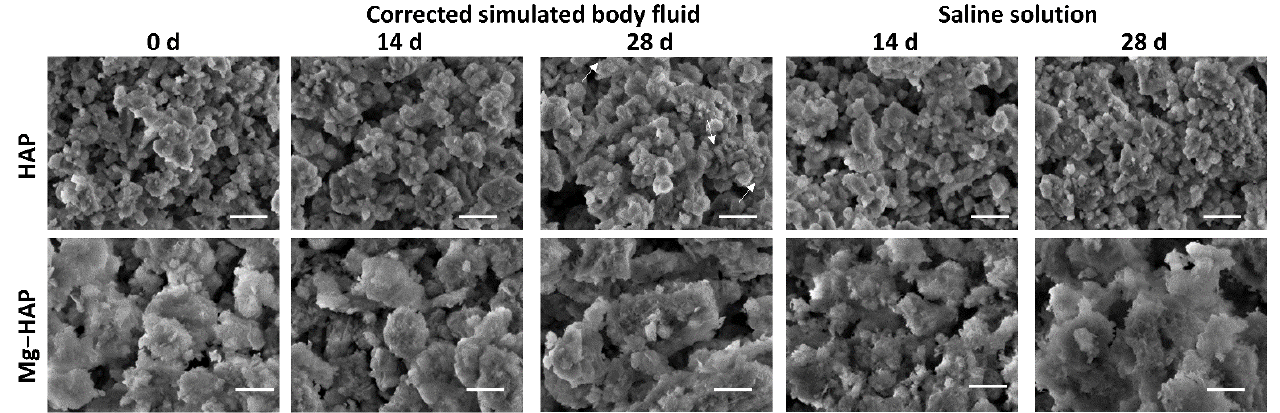
Figure 3. SEM images of non-substituted hydroxyapatite (HAP) and Mg-substituted HAP (Mg-HAP) after immersion in corrected simulated body fluid (c-SBF) and saline solution (SS) for 14–28 days at 37 °C. Scale bar is 1 μm.